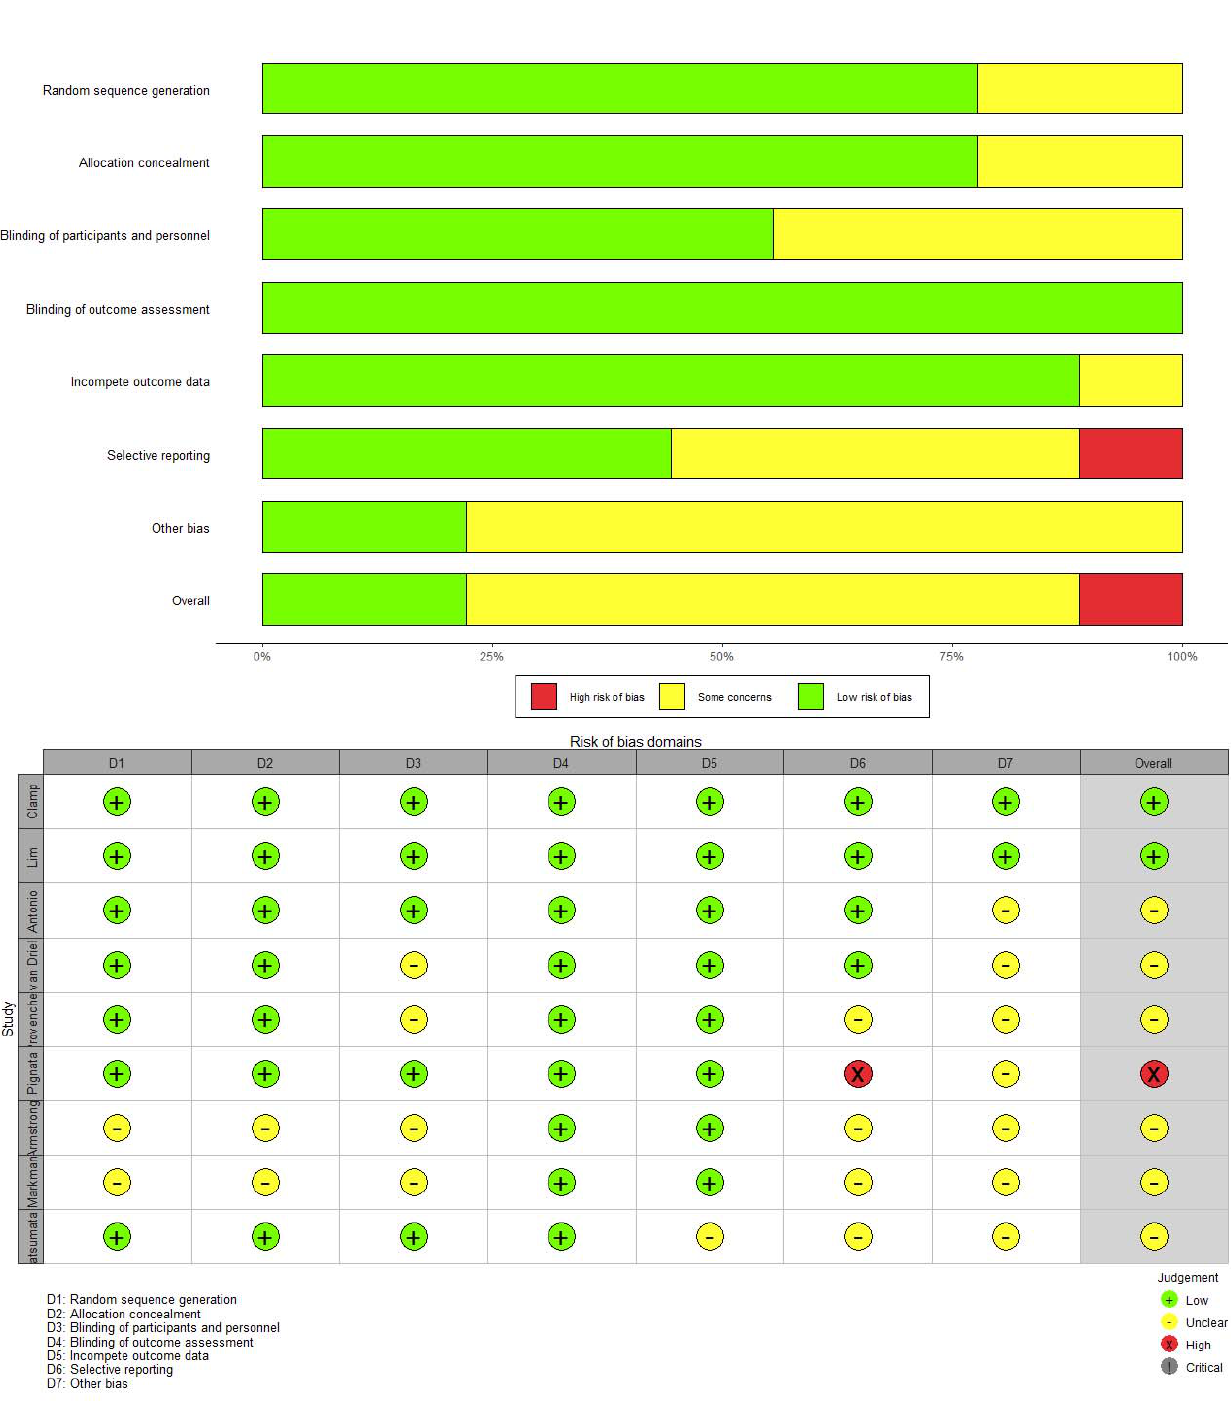
Figure 8. Risk of bias.